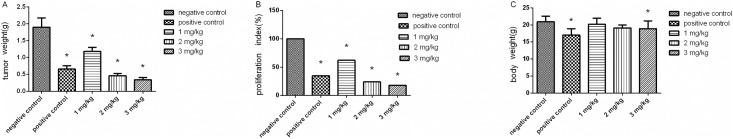
FNC significantly inhibited the growth of human JeKo-1 xenografts in vivo.(A)Graphs represent the average weight of tumors from every group. (B)shows the average proliferation index(proliferation index% = (tumor weight of drug group/tumor weight of negative control group)×100%]. (C) Graphs represent the average body weight, the body weights were measured after treatment. Tumor weights and body weights are presented as means±SD. * P<0.05 versus the control.